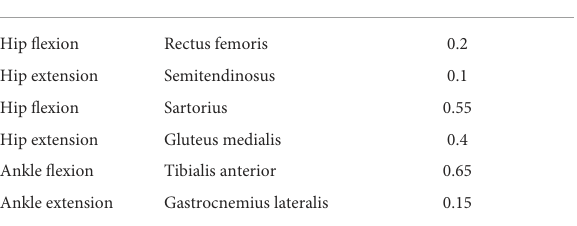
TABLE 2 Amplification coefficients for the joint movements and their associated